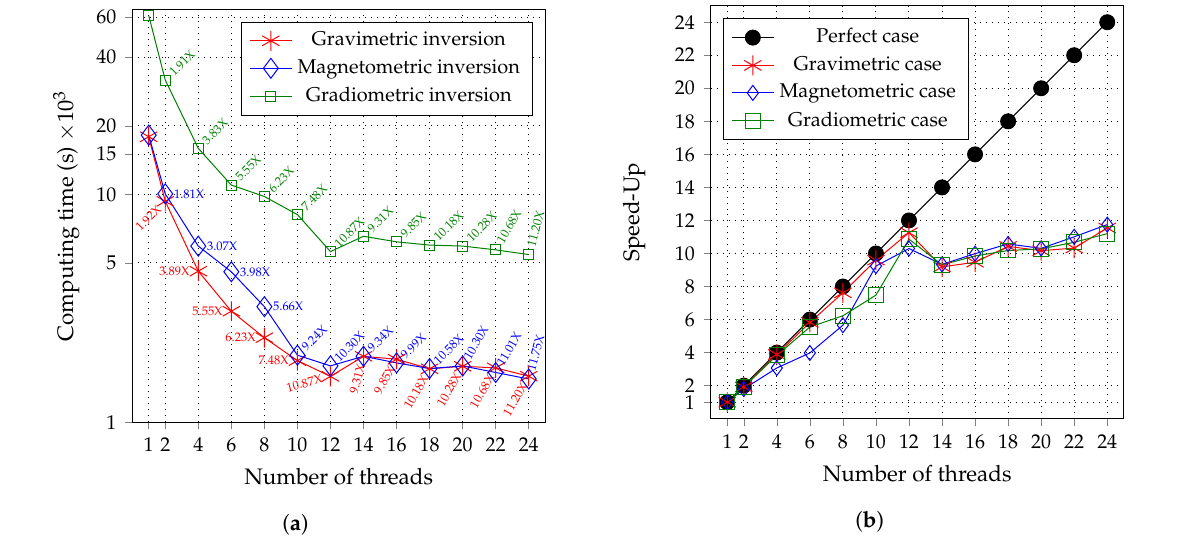
Figure 34. Performance obtained for the inverted model for the salt body. ( a ) Computing time for gravimetric (red, asterisk), magnetometric (blue, diamond) and gradiometric (green, square) inversions of the synthetic real model, respectively, as a function of (even) number of threads. ( b ) Theoretical ideal speed-up (black, circle) and obtained speed-up for gravimetric (red, asterisk), magnetometric (blue, diamond) and gradiometric (green, square) inversions of the synthetic real